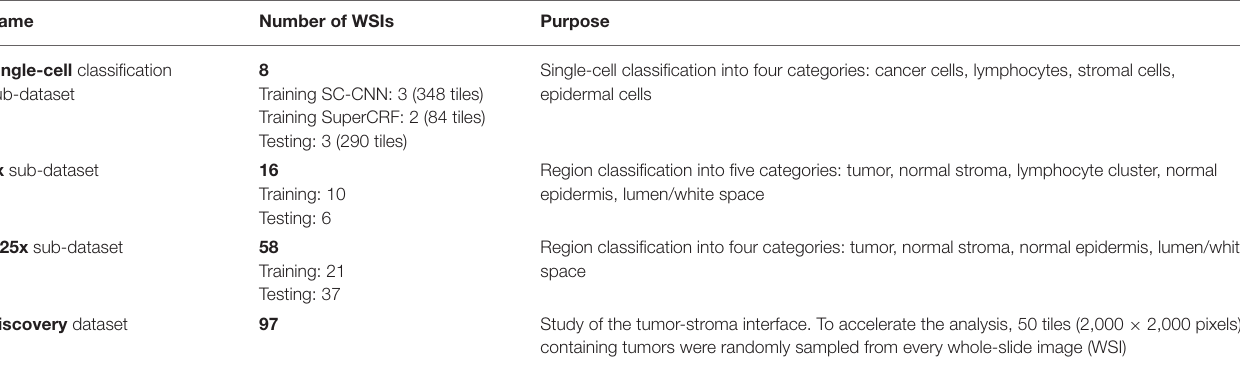
TABLE 1 | Summary of the data used to train and test the different parts of the SuperCRF system, as well as study the cancer-immune-stroma interface (also, see Supplementary Tables 1–4 ).